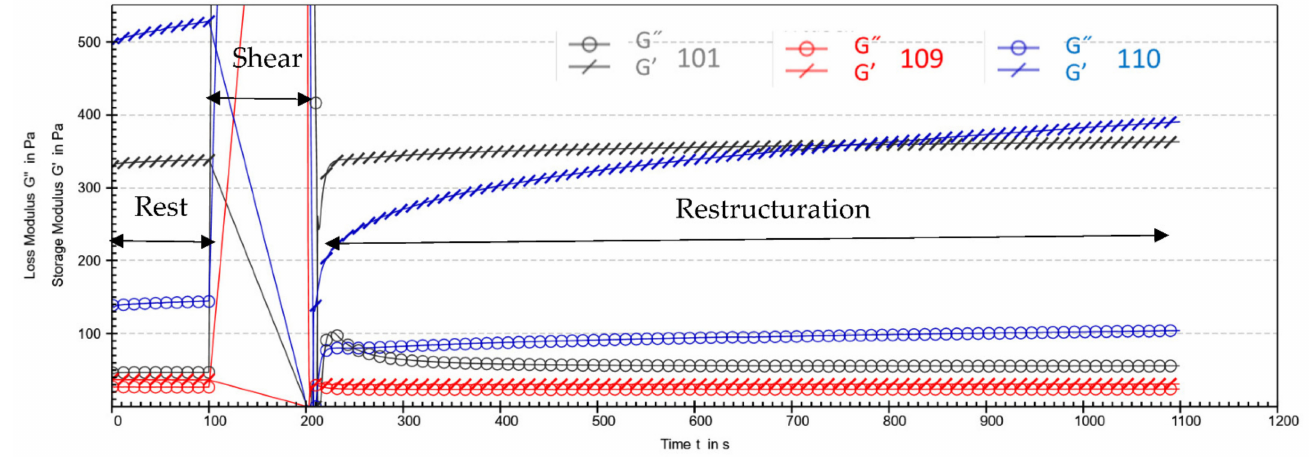
Figure 6. Viscoelasticity measurement of the 3 extreme products (101, 109 and 110) of the PCA (Figure 5) with G (cid:48) , elastic modulus, and G (cid:48)(cid:48) , viscous